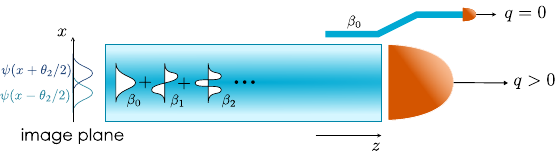
FIG. 6. Binary SPADE with evanescent coupling to only one single-mode waveguide.